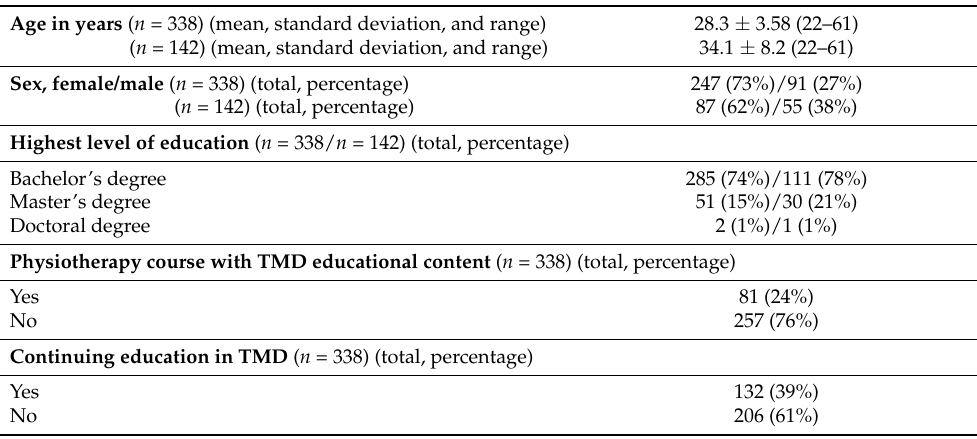
Table 1. Demographics and characteristics of the participants (total sample and sample of physiother- apists with temporomandibular disorders